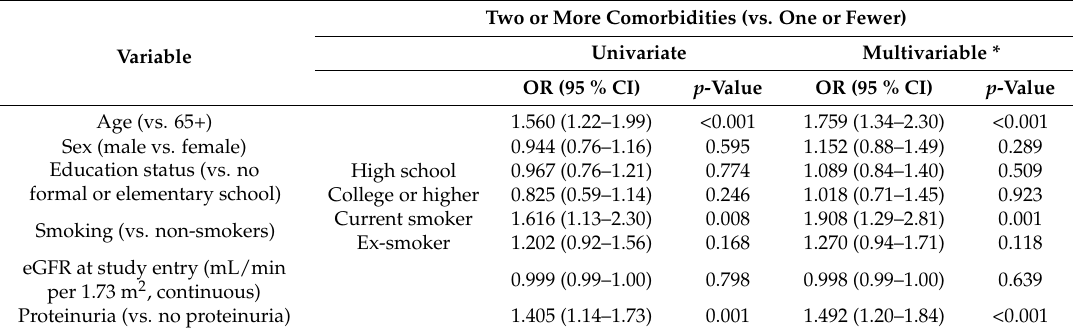
Table 3. Factors associated with multimorbidity.